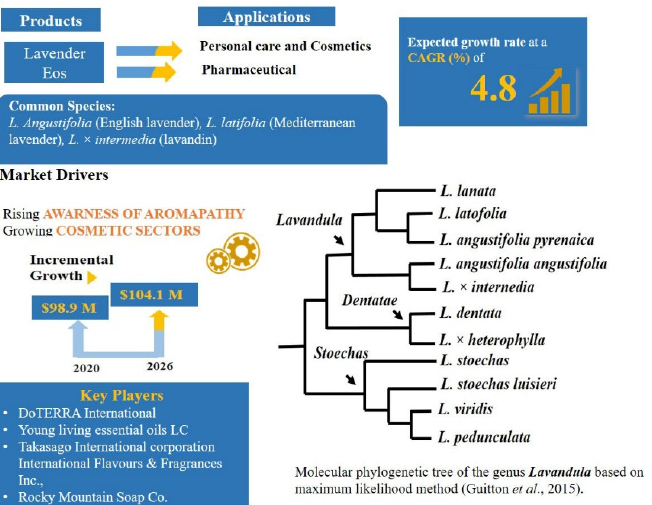
Figure 3. Lavender products market analysis [174] and phylogenetic relationship among the species.